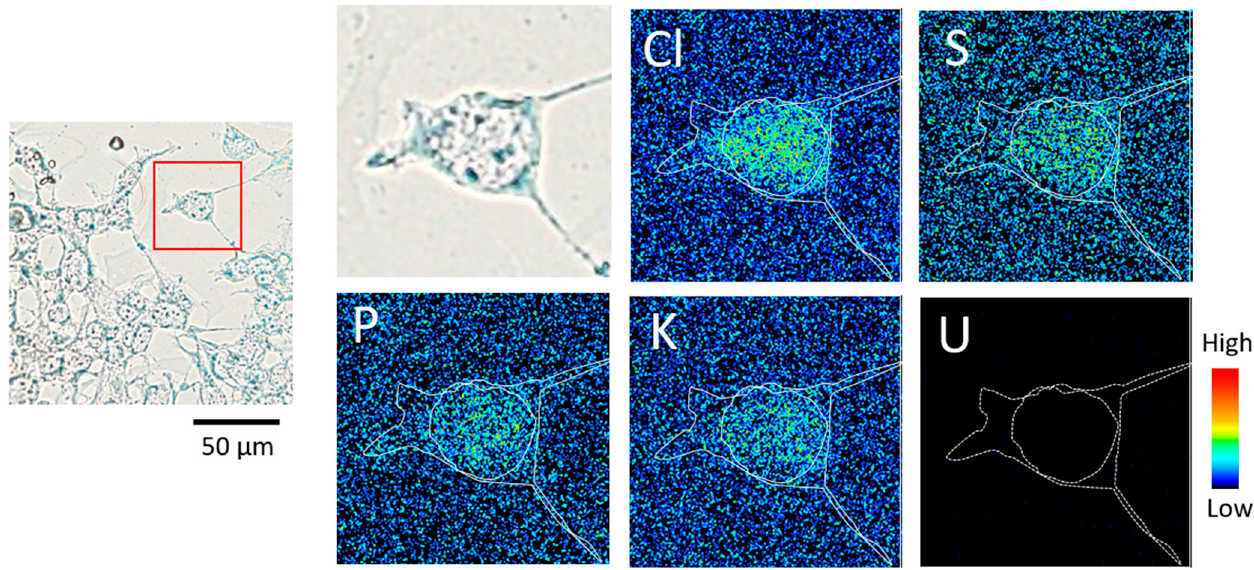
Figure 4. PIXE imaging of control S3 cells. (Left panel) Photo of control S3 cells. Elemental imaging was performed with the following conditions in the boxed area. Scanning area, 50 μ m × 50 μ m. Integrated charge, 0.2 μ C, and beam size of 1 μ m × 1 μ m.